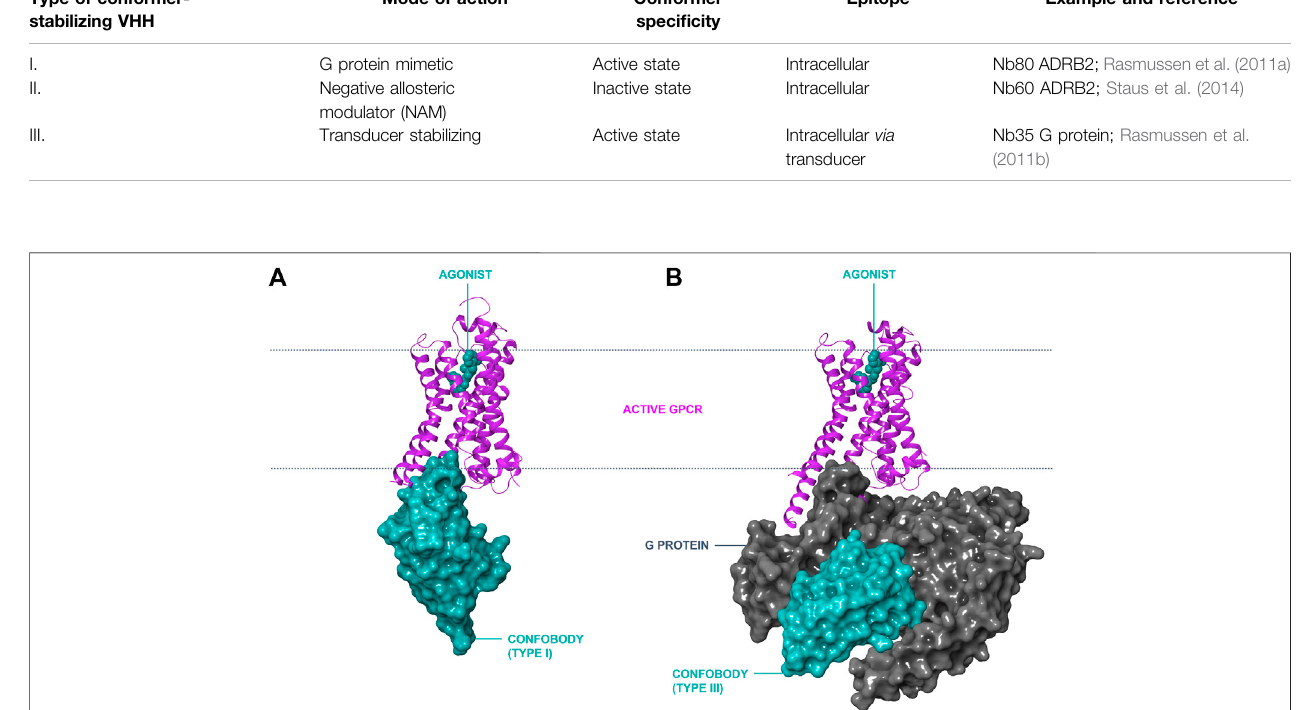
FIGURE 1 | Modes of action of conformation - stabilizing VHHs (ConfoBodies; Cbs). Cbs can stabilize disease-relevant conformational states of GPCRs as exempli fi ed by the active state ADRB2:Nb80 structure (PDB code 3P0G) depicted in panel (A) . A similar mode of interaction to a GPCR by Type II Cbs (stabilizing the inactive state conformer) is possible by protruding in the cytosolic receptor pocket (not depicted). Cbs can also stabilize protein complexes such as active GPCR:G protein complexes, as illustrated by the ADRB2:Gs:Nb35 structure (PDB code 3SN6) in panel (B) . ADRB2 is represented in magenta ribbon format; Cbs are depictedincyansurfaceformat;theGscomplexisshowningreysurfaceformat;andthesmallmoleculeorthostericagonistBI-167107isshownincyanCPKformatthe lipid bilayer is delineated with a dotted